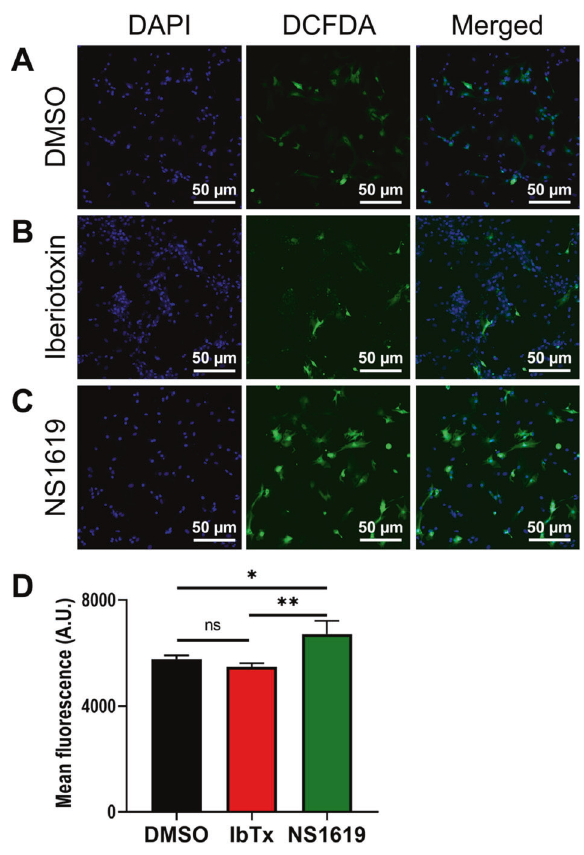
neonatal cardiomyocytes were subjected to 6 h hypoxia at 1% O 2 , 5 min of post-conditioning with DMSO, Iberiotoxin (100 nM), or NS1619 (10 μ M) followed by 12 h of reoxygenation. Cells were stained with CM-H 2 DCFDA (green) for 45 min and NucBlue ™